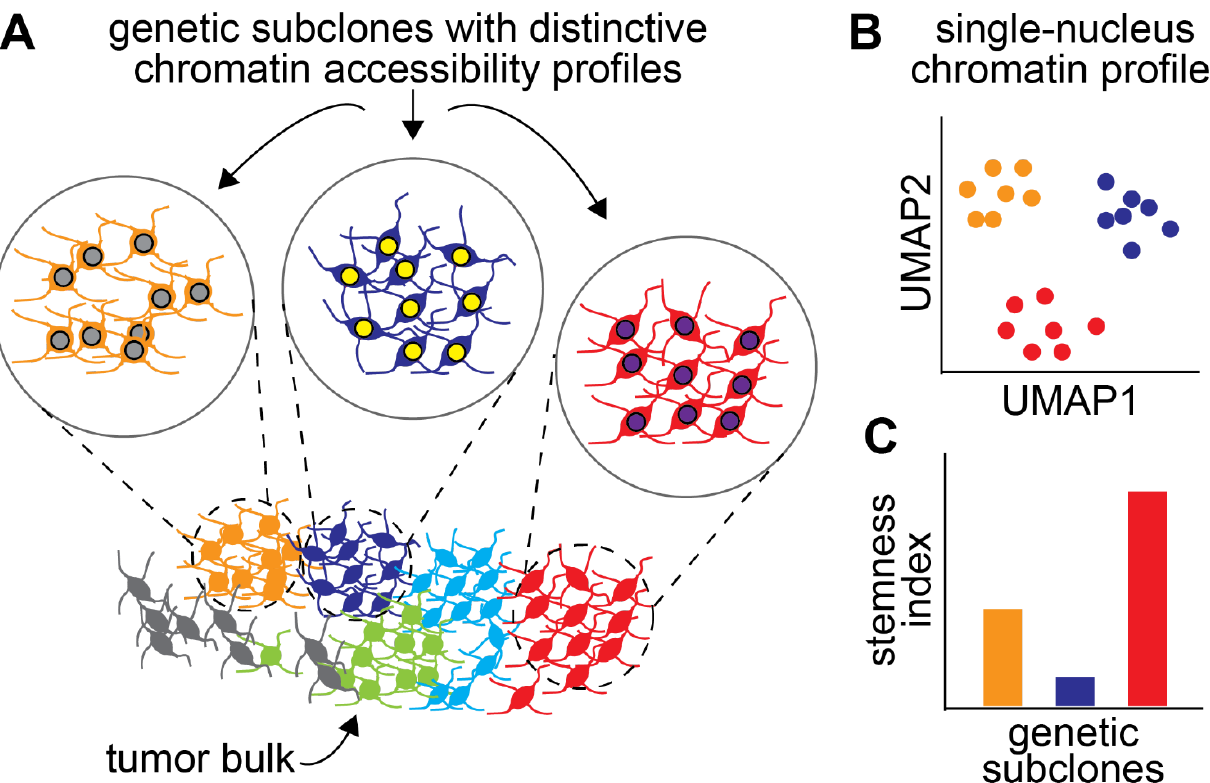
Figure 2. Genetic subclones can have characteristic chromatin landscapes. ( A ) Genetic subclones coexist in a tumour. Each colour marks cells in a subclone. Subclones can have distinctive epigenetic profiles, represented by the colour of the nuclei. ( B ) Single-cell or single-nucleus approaches such as ATAC-seq can reveal the differences in chromatin profiles between genetic subclones. ( C ) Because of their specific chromatin landscape, each subclone can be predisposed to behave like cancer stem cells or